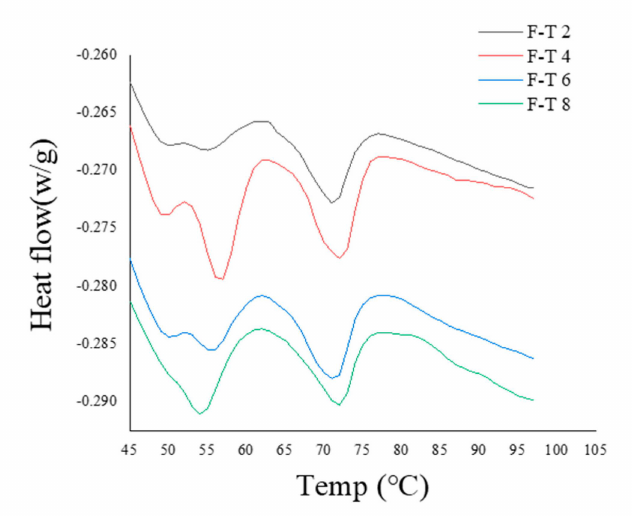
Figure 3. The DSC of the sample with different freezing–thawing (F–T) cycles.